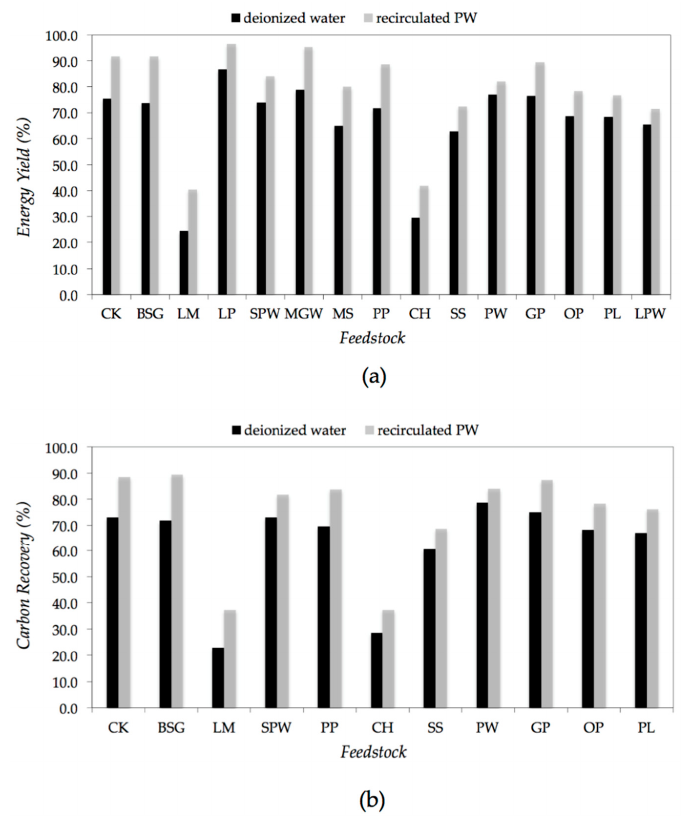
Figure 1. Effect of process water recirculation on energy yield ( a ) and carbon recovery ( b ) from biomass.